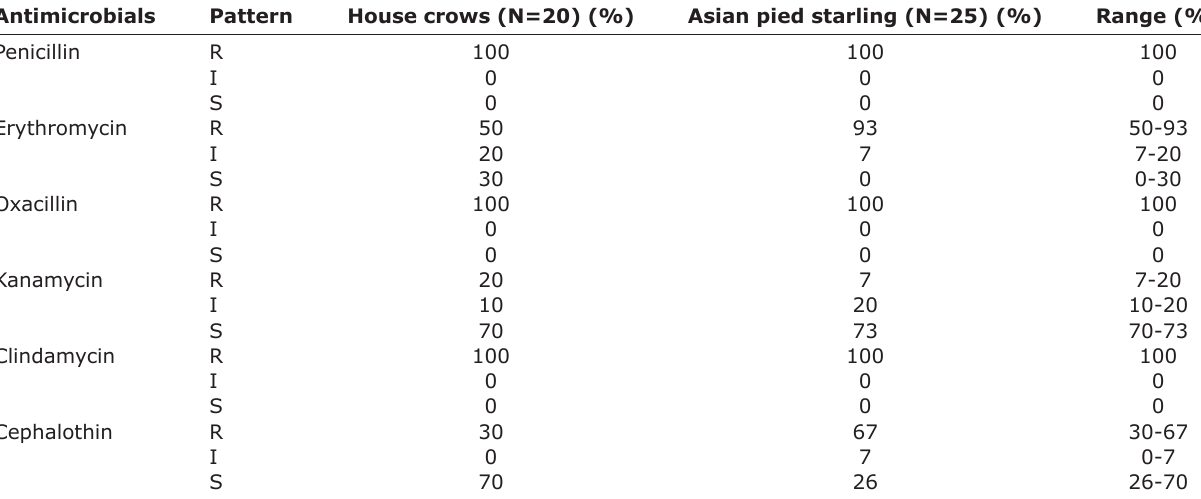
Table-4: Patterns of multidrug resistance in isolates of Salmonella from two different species.